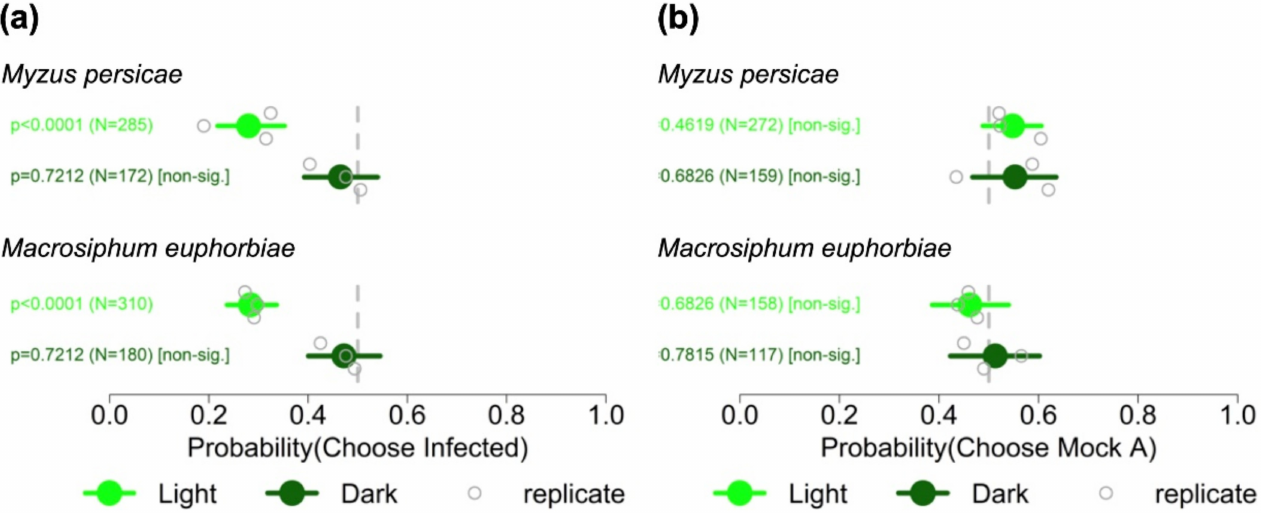
Figure 2. Summary of adhesive strip trapping experiments to determine the initial preferences of aphids for mock-inoculated tomato plants or plants infected with Fny-CMV in the dark or under illumination. Aphids ( Myzus persicae and Macrosiphum euphorbiae ) were released between pairs of tomato plants that had been mock-inoculated or inoculated with Fny-CMV (21 days previously) ( a ) or between pairs of mock-inoculated plants ( b ), to control for any additional stimuli or biases in the experimental set-up under illumination (Light) or in the dark. Adhesive traps were present between the release point and each plant, and at 1 h post-release trapped aphids were counted to assess their initial direction of travel. The x -axis shows the range of the 95% credible interval of the probabilities of travel of aphids towards the variously treated plants with values for each of three independent experiments (replicate) indicated. The total number of aphids (N) investigated for each comparison is indicated and statistical significance or non-significance was determined using binomial tests. The vertical grey dotted lines indicate a probability of 0.5 of a preference for migrating towards infected versus mock-inoculated plants, i.e., no significant difference in